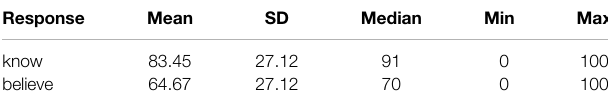
TABLE 4 | Mean evidentiality ratings by utterance for the